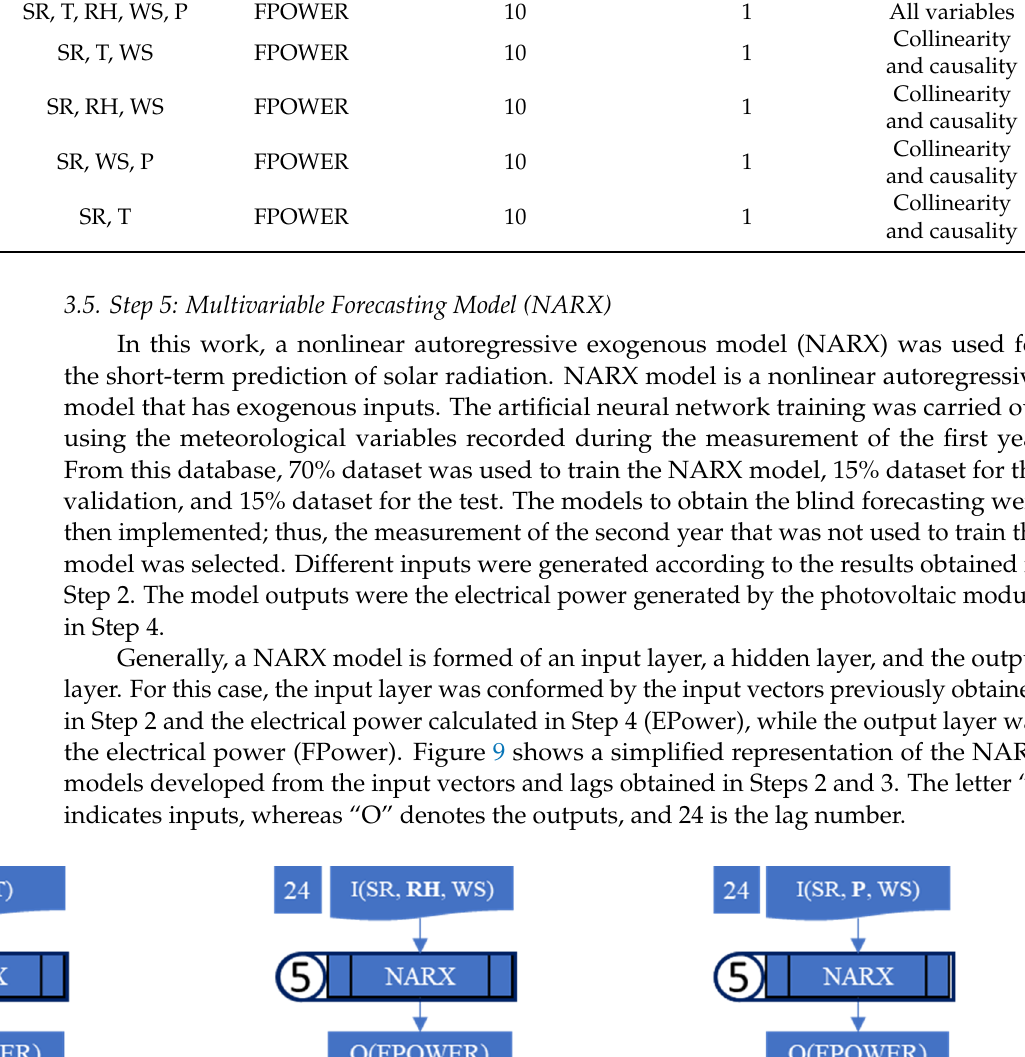
Figure 10. The general arrangement of the neural networks model. A test was made first using all variables to determine the effectiveness of the proposed methodology. Then, using the input vectors and lags previously selected, the different architectures of the NARX models are described in Table 7. The simplest model was the H-NARX model, and it is a NARX model with two input neurons (SR and T), ten hidden neurons, 24 lags and one output neuron (electrical power). This simple model was compared with model NARX I (all the variables are used as inputs), NARX II (input